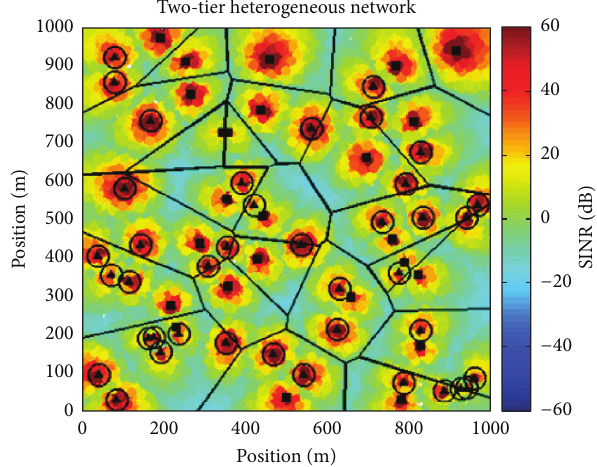
Figure 2: SINR for HetNets with open access